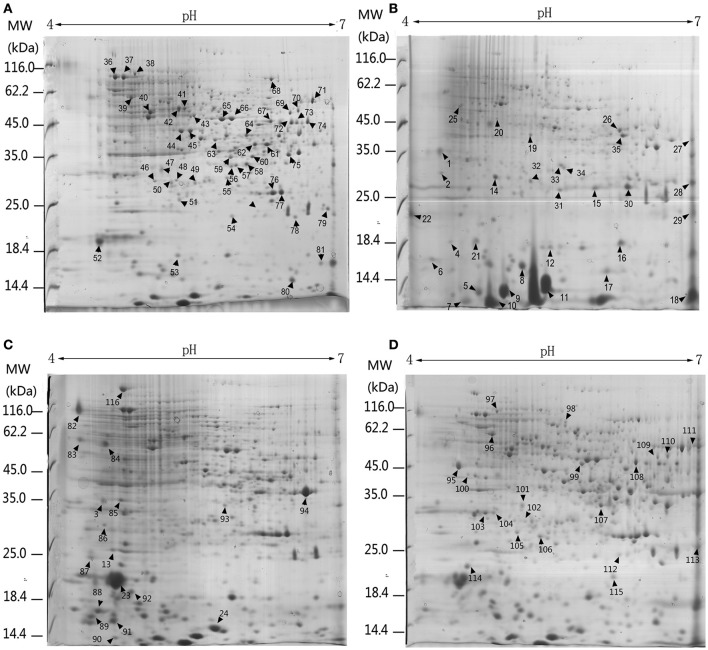
2-DE analysis of differential expressed proteins in P. ostreatus grown in liquid substrates supplemented with different components of lignocellulose. Arrows and numbers refer to differential expressed proteins (A) Kirk's liquid medium (control). (B) Kirk's liquid medium supplemented with lignin; (C) xylan; (D) CMC. The pH of the isoelectric focusing gel ranging from 4 to 7 is shown on the top of each gel. Protein ladder (molecular weight, MW) is shown on the left of the gels.